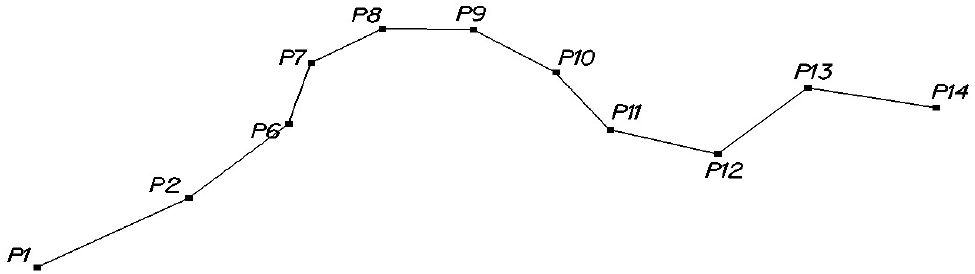
Figure 4. Line string after generalization.